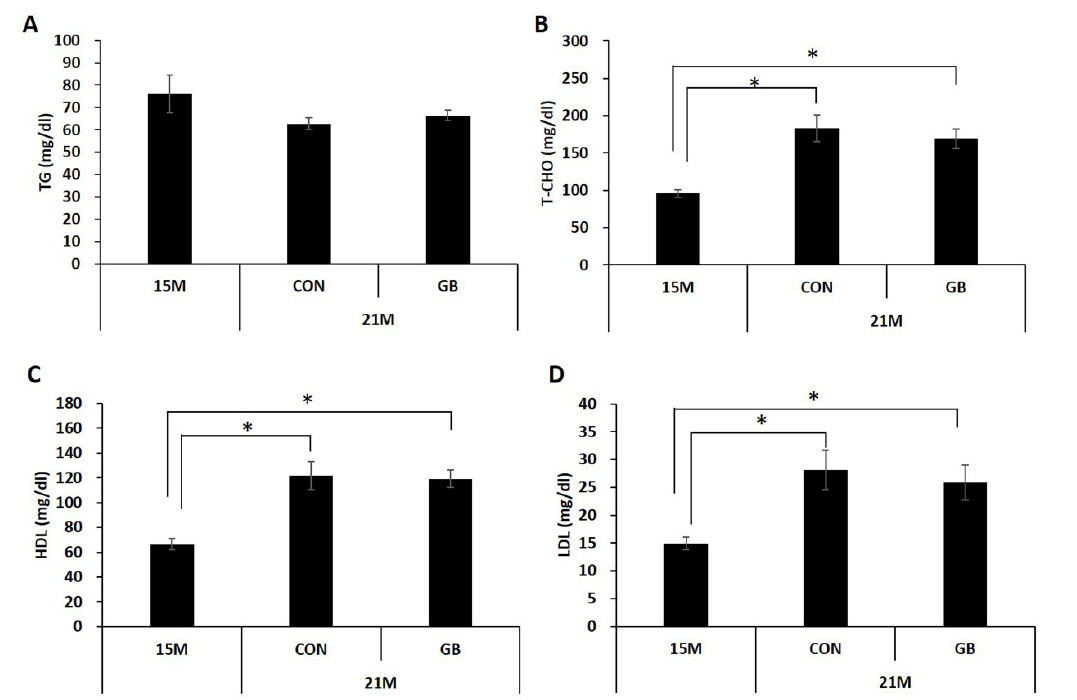
Figure 2. Ginseng berry (GB) extract supplementation does not change plasma lipid profile in aged mice. Fifteen-month-old mice were fed a regular diet (CON) or a regular diet supplemented with 0.05% GB extract for 6 months. ( A ) Triglyceride (TG); ( B ) total cholesterol (T-CHO); ( C ) HDL-cholesterol and ( D ) LDL-cholesterol level in the plasma were measured at 21 months of age. Values are mean ± SE, ( n = 8 group −1 ), * p < 0.05.